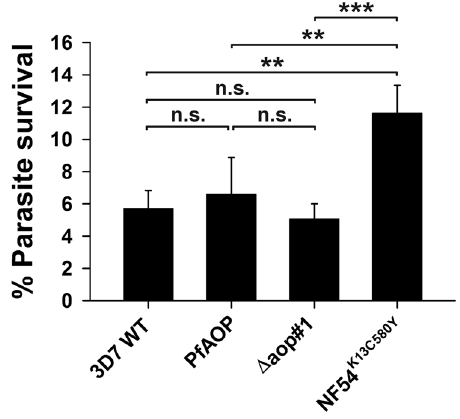
Figure 7. Ring-stage survival assays. Highly synchronous ring stage parasites were treated with or without 700 nM artemisinin for 6 h, washed and further incubated for 66 h. The parasitemia was subsequently determined from Giesma-stained blood smears. The parasite survival percentage was calculated for wild type strain 3D7 (3D7 WT), a strain overexpressing GFP-tagged full length PfAOP from Fig. 3 (PfAOP), a knockout strain from Fig. 4 ( Δ aop#1) and a positive control that carries the mutation for K13 C580Y (NF54 K13C580Y ). All data are the mean ± standard deviation of four independent experiments. Statistical analyses were performed in SigmaPlot 12.5 using the one way ANOVA method. Results are summarized on top of the bar chart (n.s., not significant; ** p < 0.01; *** p <